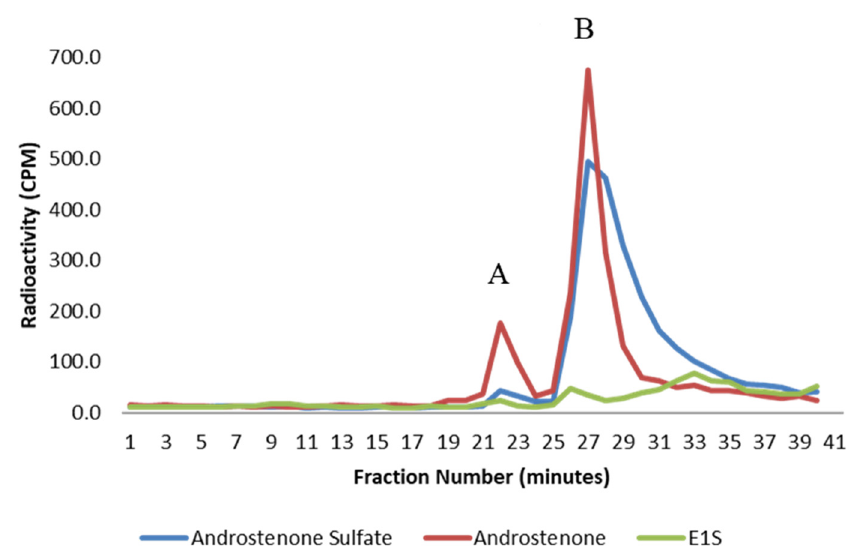
Figure 3. A graph showing the binding of androstenone sulfate (blue), free androstenone (red), and E 1 S (green) in porcine plasma following HPLC gel filtration. Bound and unbound steroid peaks are represented by A and B, respectively. Values are expressed as the mean from three separate experiments.